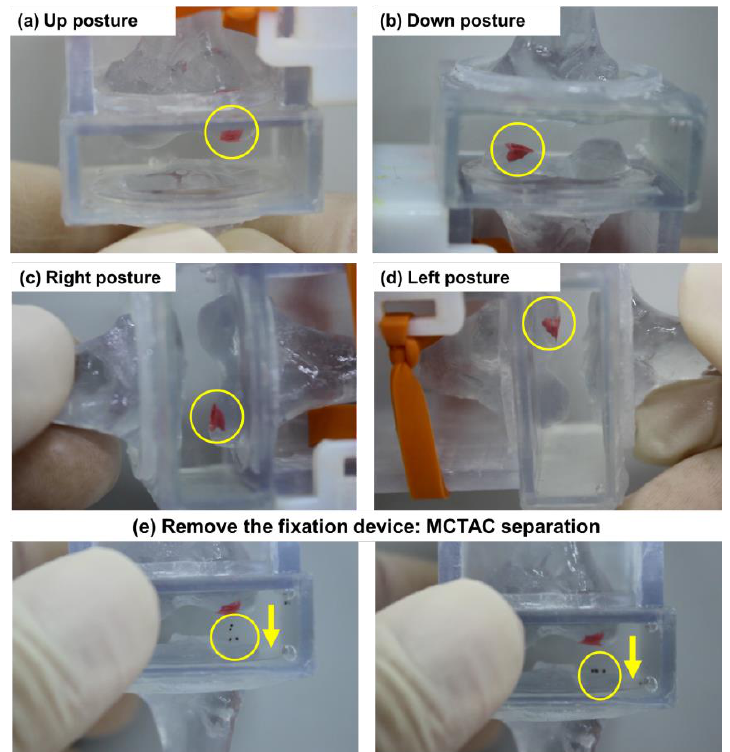
Figure 8. Results of the in-vitro experiments for di ff erent knee postures: ( a ) up posture, ( b ) down posture, ( c ) left posture, ( d ) right posture, and ( e ) separation of the MCTAC from the targeted lesion on removing the fixation